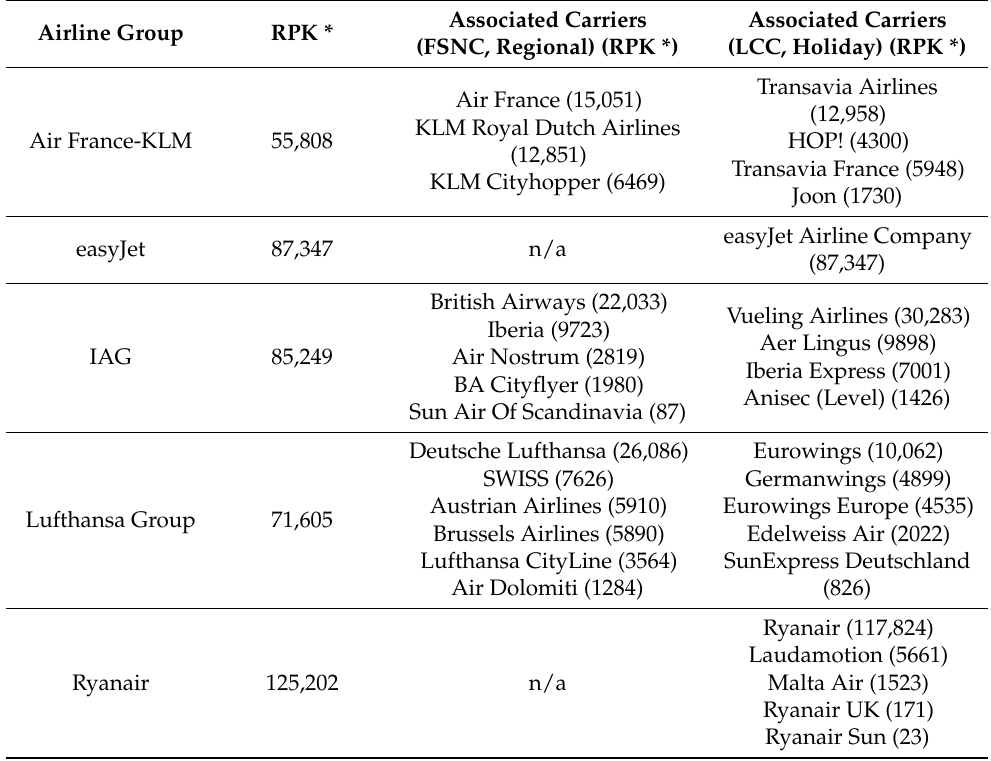
Table 1. Top five European airline groups in 2019. Airline